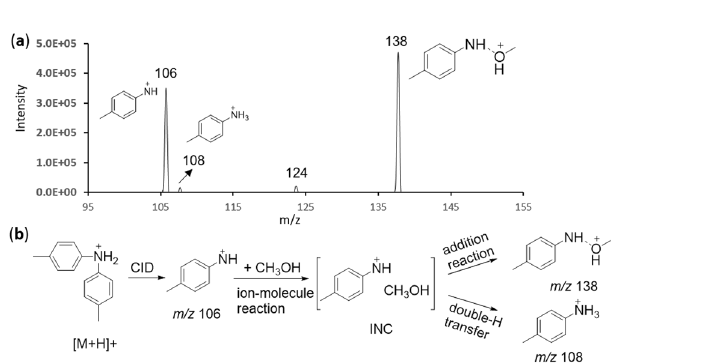
Figure 6. Gas phase ion/molecule reaction spectrum of p -methylphenylnitrenium ion and methanol, reaction time 1 s ( a ), and proposed reaction mechanism between p -methylphenylnitrenium ion (generated from the fragmentation of protonated di- p -tolylamine) and methanol ( b ).